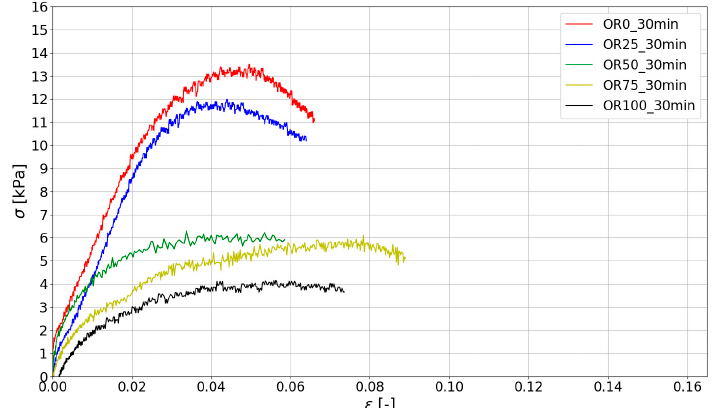
Figure 10. Stress–strain curves for mixes at 15 min after adding water.